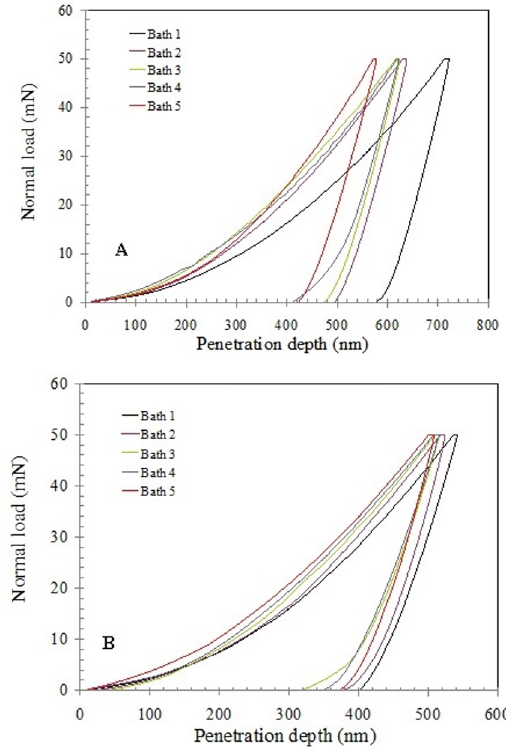
Figure 8. Load versus penetration depth curves for the coatings obtained in baths with different tungsten concentrations: a) As- deposited; b) annealed at 400 ºC for 1 h. Table 4. Hardness (H), Young's modulus (E) and H/E ratio of the coatings produced in baths 1 to 5 in the as-deposited condition.